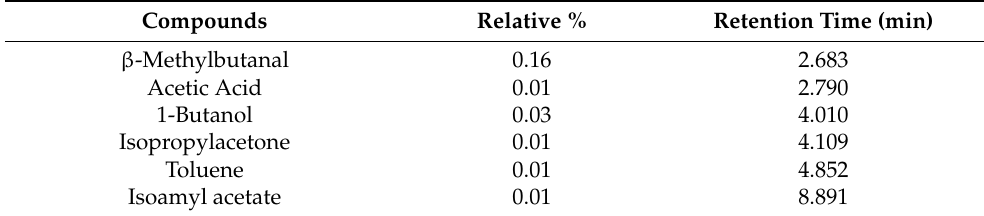
Table 3. Chemical composition of EO assessed by GC